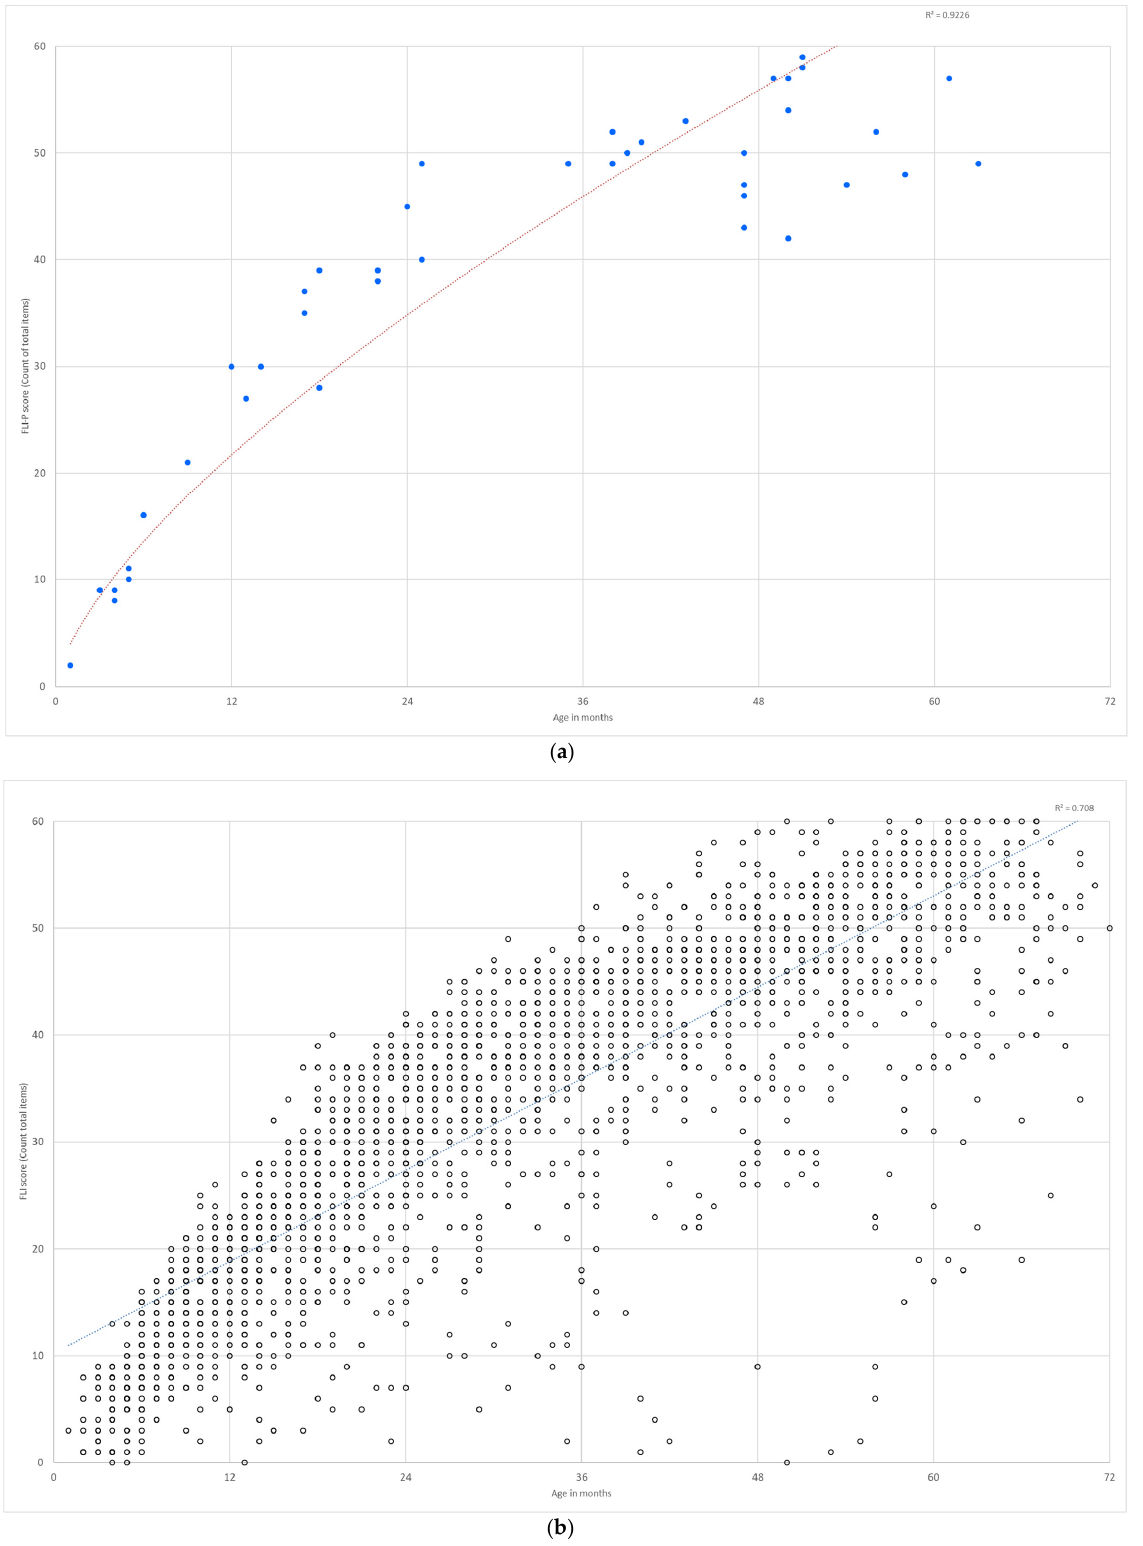
Figure 6. FLI-P scores ( a ) for children in the typical hearing group ( n = 27 children, 46 data points) show an increase in listening skills with age and variability in scores for children at 4 years of age and ( b ) comparative scores for the early intervention group ( n = 451 children, 2340 data points). A comparison of FLI-P scores for children in the EI and TH groups indicate expected differences (larger variation and less developed listening skills across age ranges exclud- ing children with an additional disability for the purposes of comparison). Results demon- strate that a number of children with hearing loss achieved similar FLI-P scores to children in the TH group. Lines of best fit indicate significant linear relationships for both the TH group ( 𝑅 (cid:2870) = 0.80) and the EI group ( 𝑅 (cid:2870) = 0.70), despite large numbers and variability in the EI group. 3.3.2. Bilateral and Unilateral Hearing Loss The FLI-P results for children with bilateral hearing loss ( n = 385, 2130 FLI-P scores) were compared to FLI-P results for children with unilateral hearing loss ( n = 140, 696 FLI- P scores) (Figure 7). Results indicate similar FLI-P scores across ages for both groups de- spite the expectation that children with unilateral hearing loss may have better FLI-P scores as they have one ‘good ear’ and results would be more similar to typical hearing children. 𝑅 (cid:2870) values indicate similarly strong linear relationships, with a mildly stronger relationship for children with unilateral hearing loss ( 𝑅 (cid:2870) = 0.79) than for children with bilateral hearing loss ( 𝑅 (cid:2870) = 0.69).